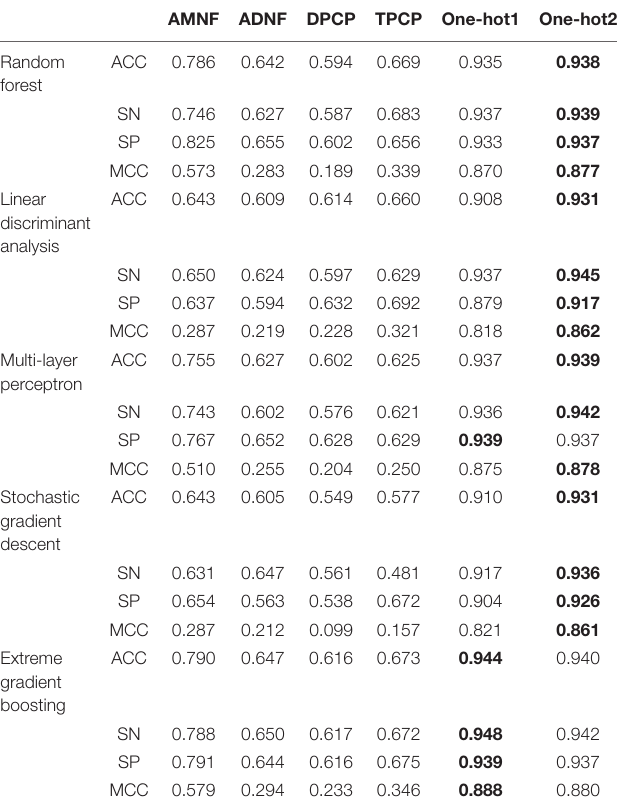
TABLE 2 | Indicators of different features and classifier